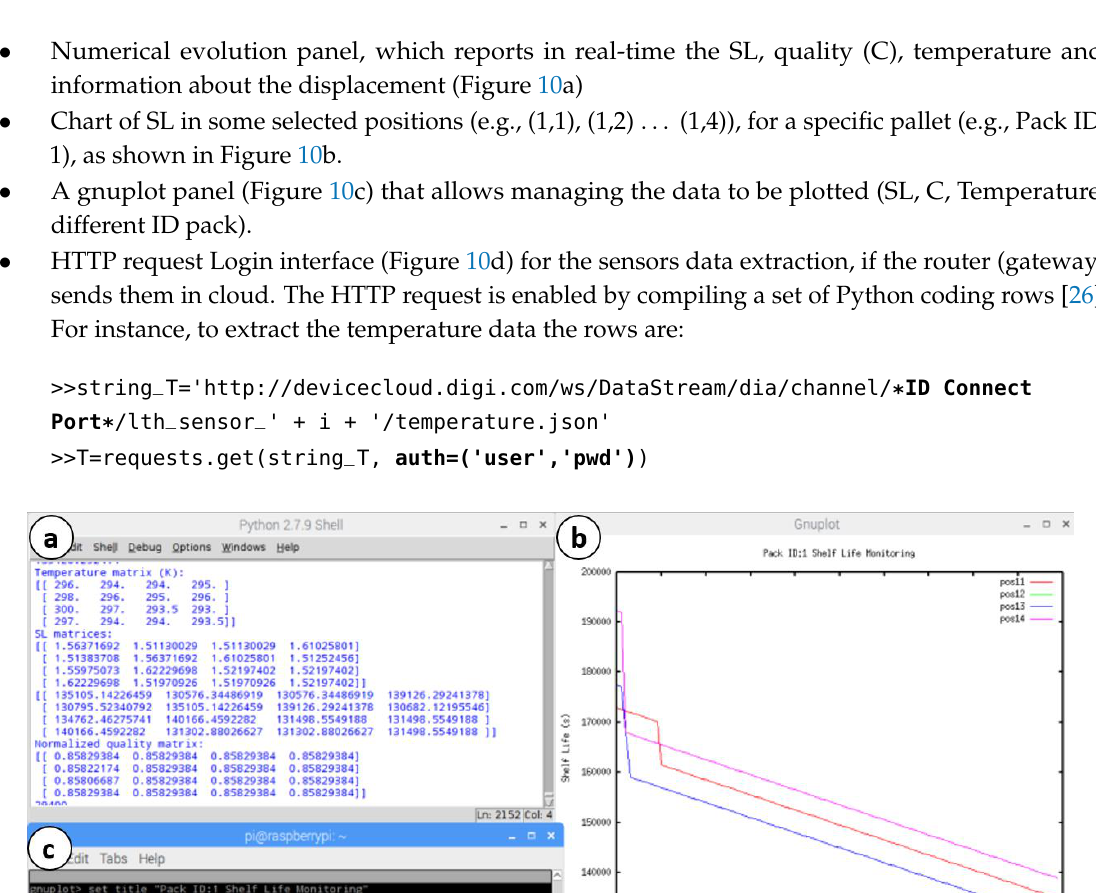
Figure 10 expands the Central Control Unit panel, highlighting four main parts: